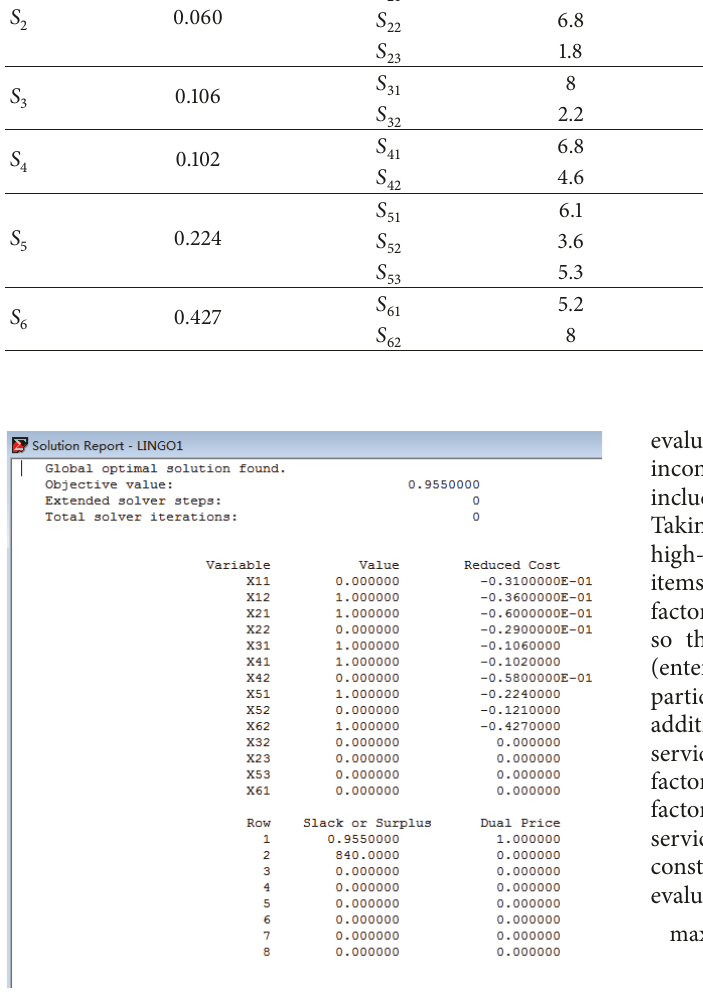
Figure 8: The service items selection diagram of